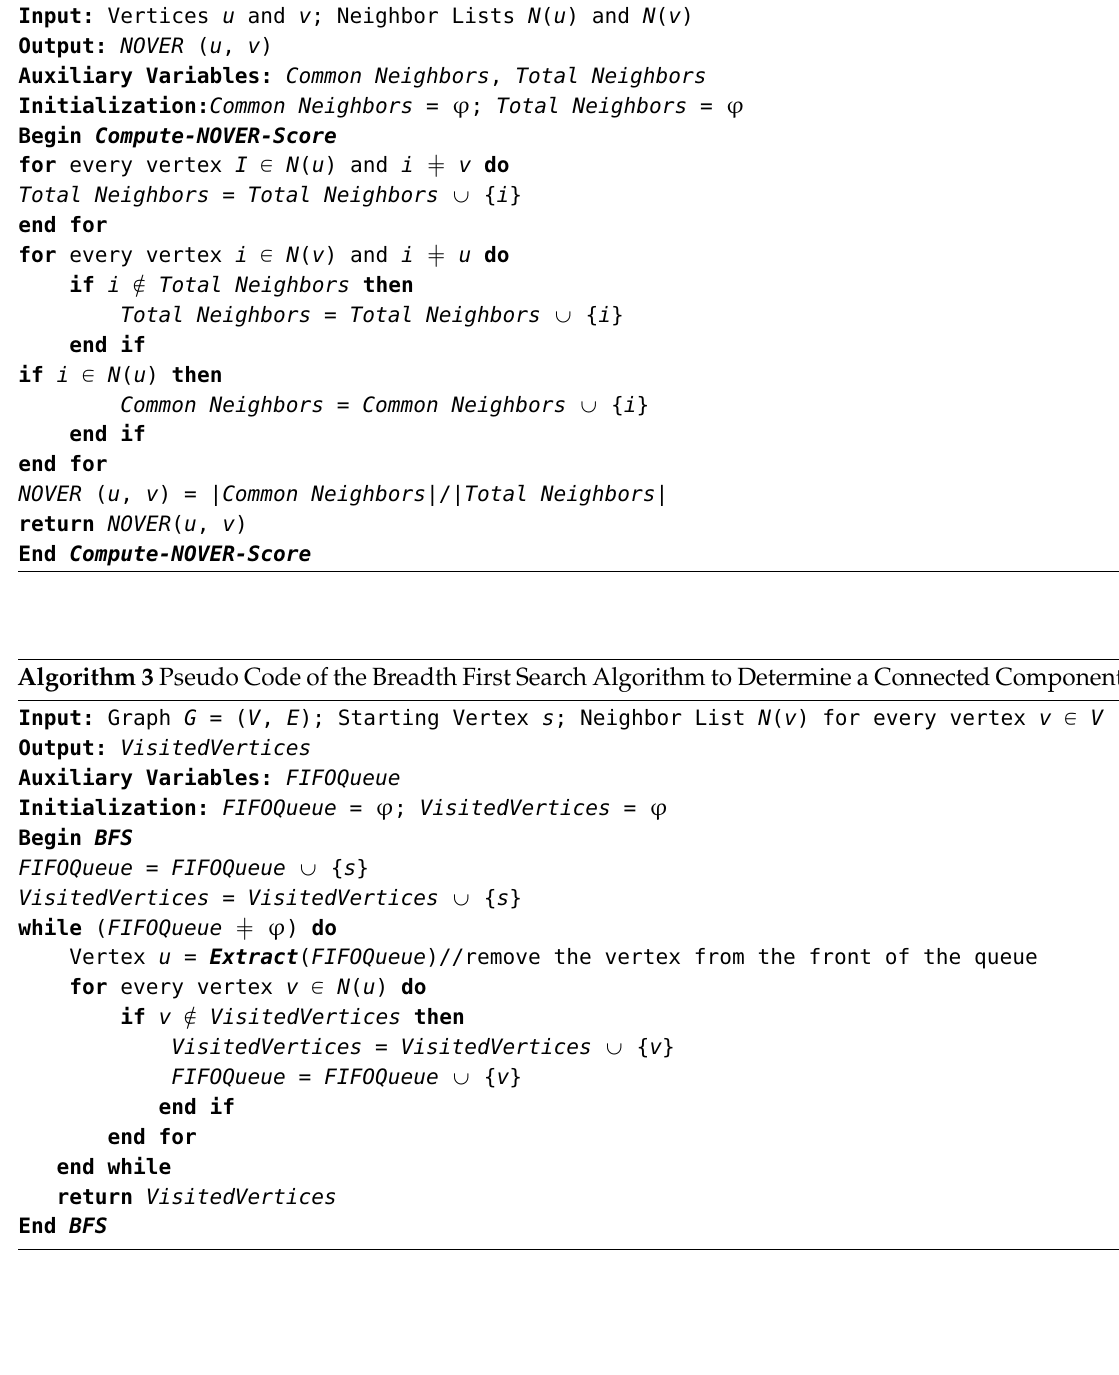
Algorithm 2 Pseudo Code to Determine Neighborhood Overlap Score for an Edge